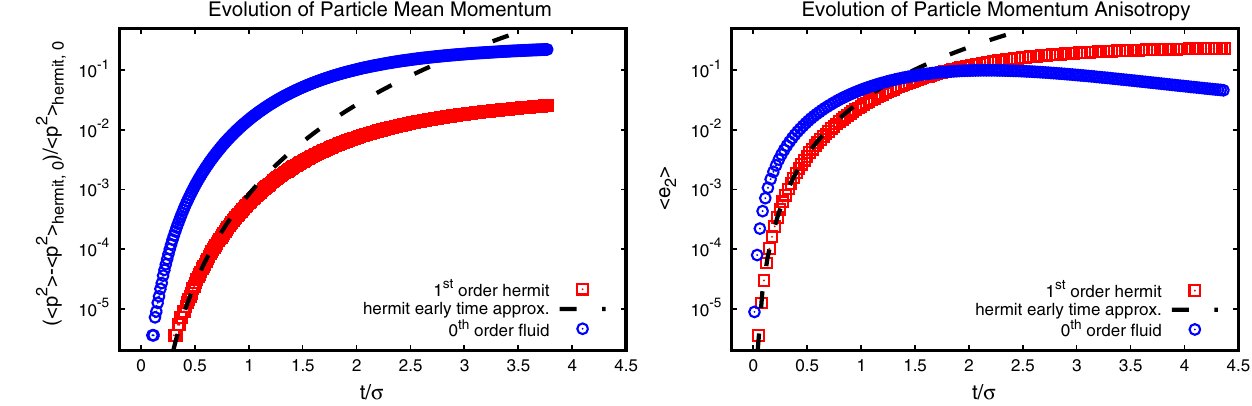
Fig. 2 Left: Time evolution of particle mean square momentum (cid:9) p 2 (cid:10) for a single Gaussian hot-spot of width σ . Right: Time evolution of mean elliptic momentum anisotropy for two Gaussian hot-spots located